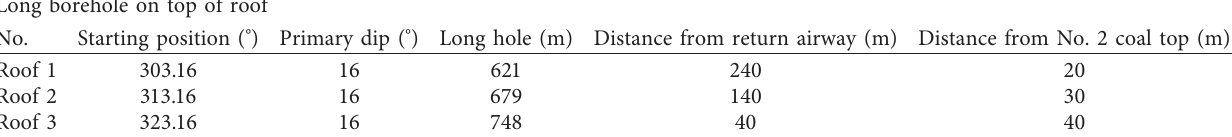
Figure 6: Layout of the directional long hole in the surrounding rock. Table 2: Design parameters of three-dimensional pumping directional drilling.